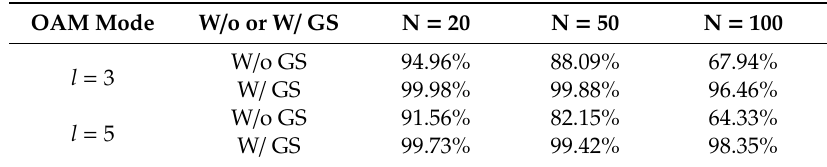
Table 1. The power density (PD) values of orbital angular momentum (OAM) beams without (W / o) and with (W) GS algorithm corresponding to Figure